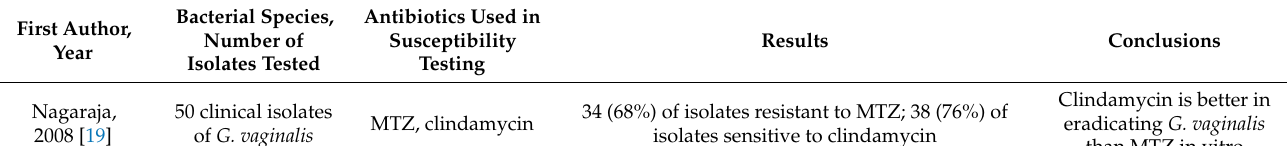
Table 1. In vitro data on antibiotic drug resistance in BV-associated